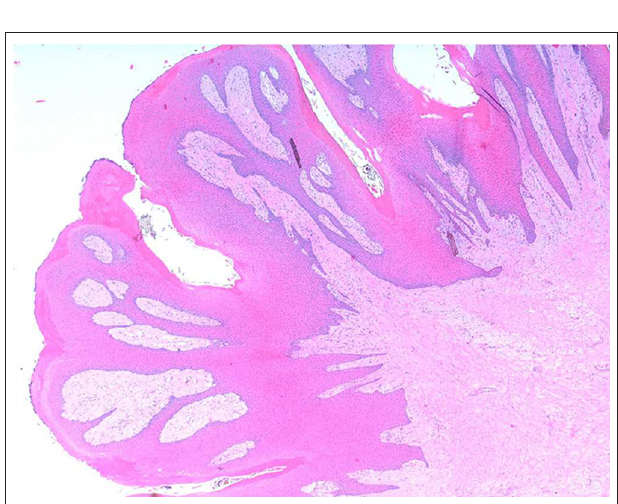
FIGURE 10 | Gingival mass, roe deer; cross section of the papillary projection; H&E